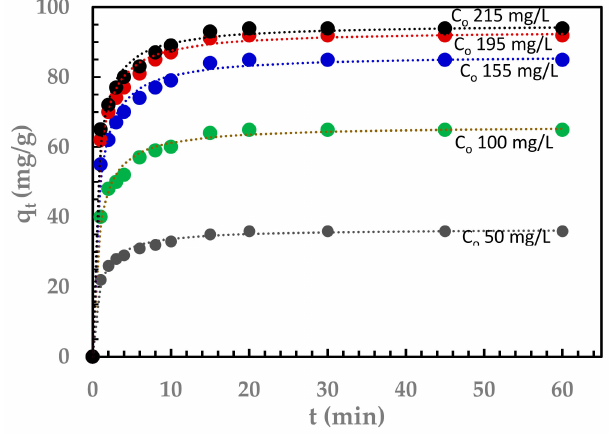
Figure 7. PSO model fitted to adsorption of five initial concentrations of Sr. GO dose = 20 mg, liquid volume = 100 mL, pH = 5, and T = 25 ◦ C.